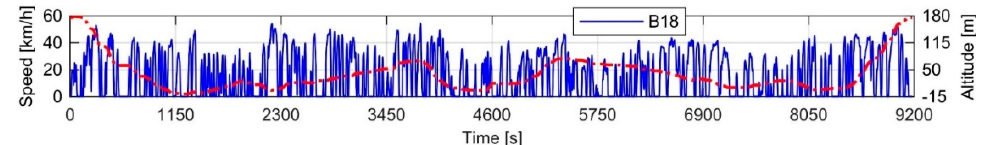
Figure A4. Berkeley bus line 18 driving cycle.